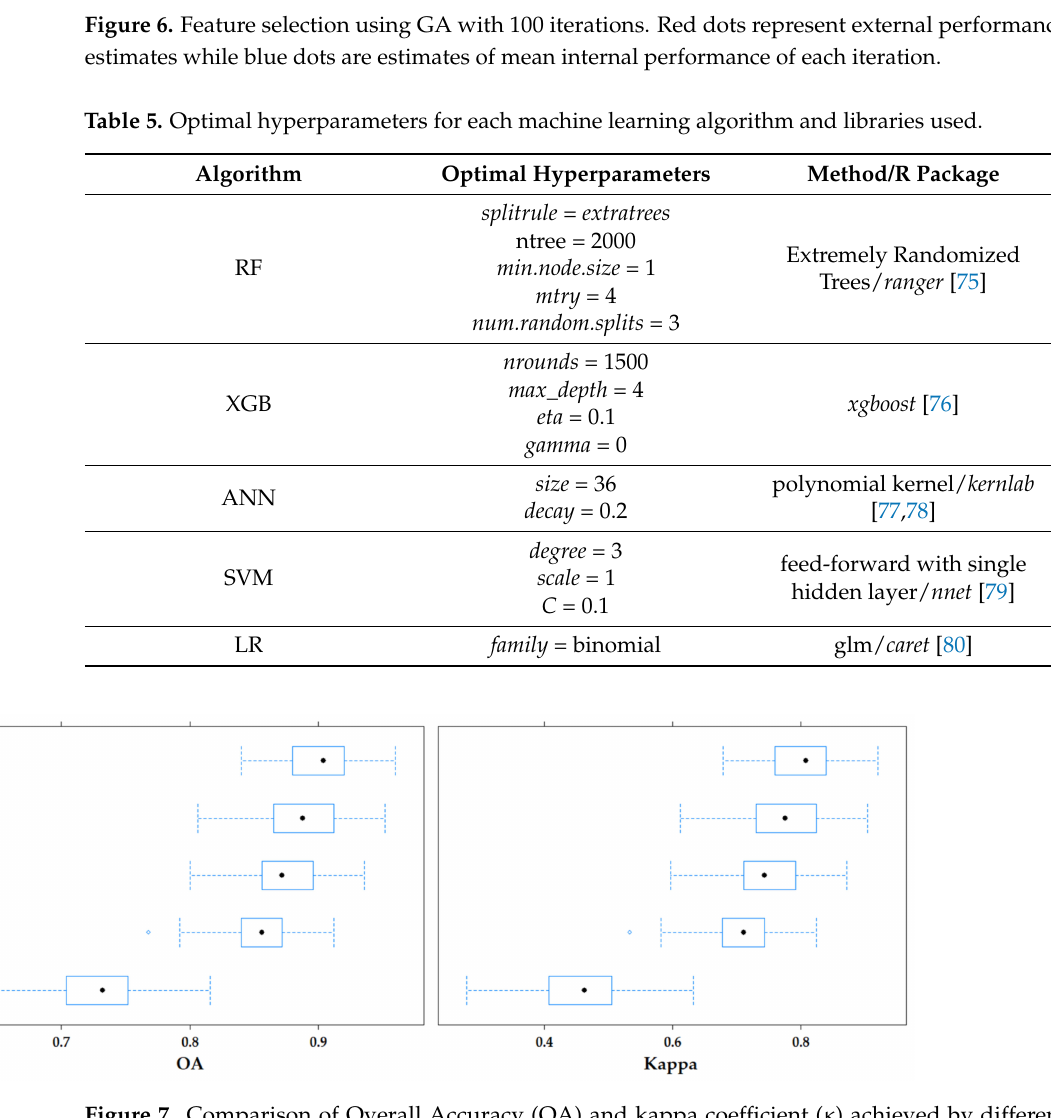
Figure 7. Comparison of Overall Accuracy (OA) and kappa coefficient ( κ ) achieved by different classifiers on the training